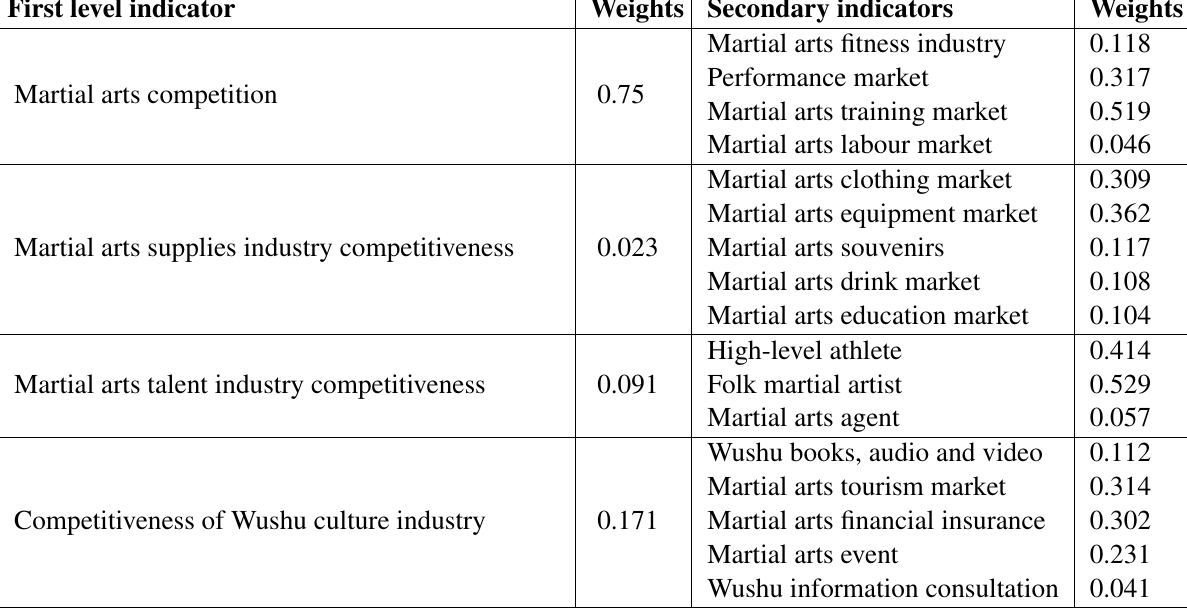
Table 2 The weight distribution of the core competitiveness evaluation index of the martial arts